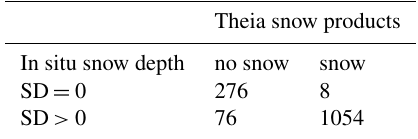
Table 5. Confusion matrix between the Theia snow products and in situ snow depth data (SD).